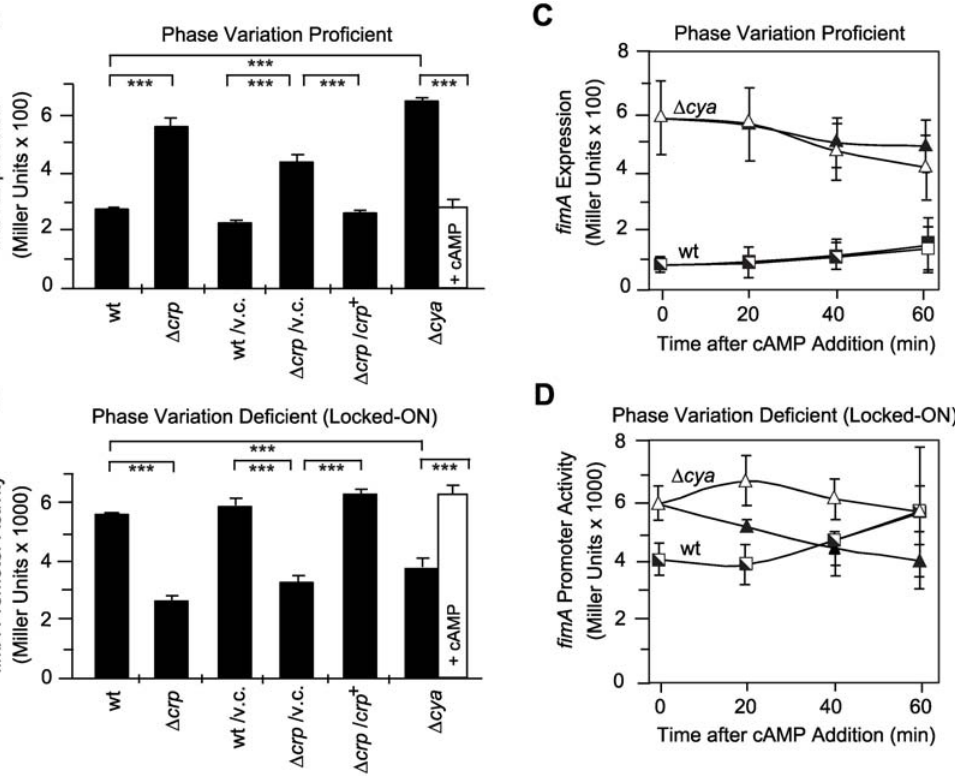
Figure 1. Effect of CRP-cAMP deficiency on the expression of the fimA gene. (A–B) fimA expression was monitored by measuring ß- galactosidase activity from a chromosomal transcriptional fimA-lacZ fusion in either phase variation proficient (A) or phase variation deficient (B) strain backgrounds. For complementation purposes, plasmid pCBP68 ( crp + ) carrying the crp gene in the vector pLG338 (v.c.) was used. Bacterial cultures were grown in LB medium at 37 u C to mid-log phase. Black bars represent values derived from cultures grown without cAMP and white bars represent values obtained from cultures grown in presence of 5 mM cAMP. Strains used in A: CBP198 (wt), CBP199 ( D crp ), and CMM198 ( D cya ); Strains used in B: CBP374 (wt), CBP375 ( D crp ), and CMM374 ( D cya ). (C–D) Effect of addition of 5 mM cAMP (open symbols) on fimA expression in either phase variation proficient (C) or phase variation deficient (D) strain backgrounds. Bacterial cultures were grown in LB medium at 37 u C to an OD 600nm of 0.05 before the addition of cAMP. As controls, cultures with no addition of cAMP (filled symbols) were used. Strains used in C: CBP198 (wt, squares) and CMM198 ( D cya , triangles). Strains used in D: CBP374 (wt, squares) and CMM374 ( D cya , triangles). All results shown are the mean values and standard deviations from three independent